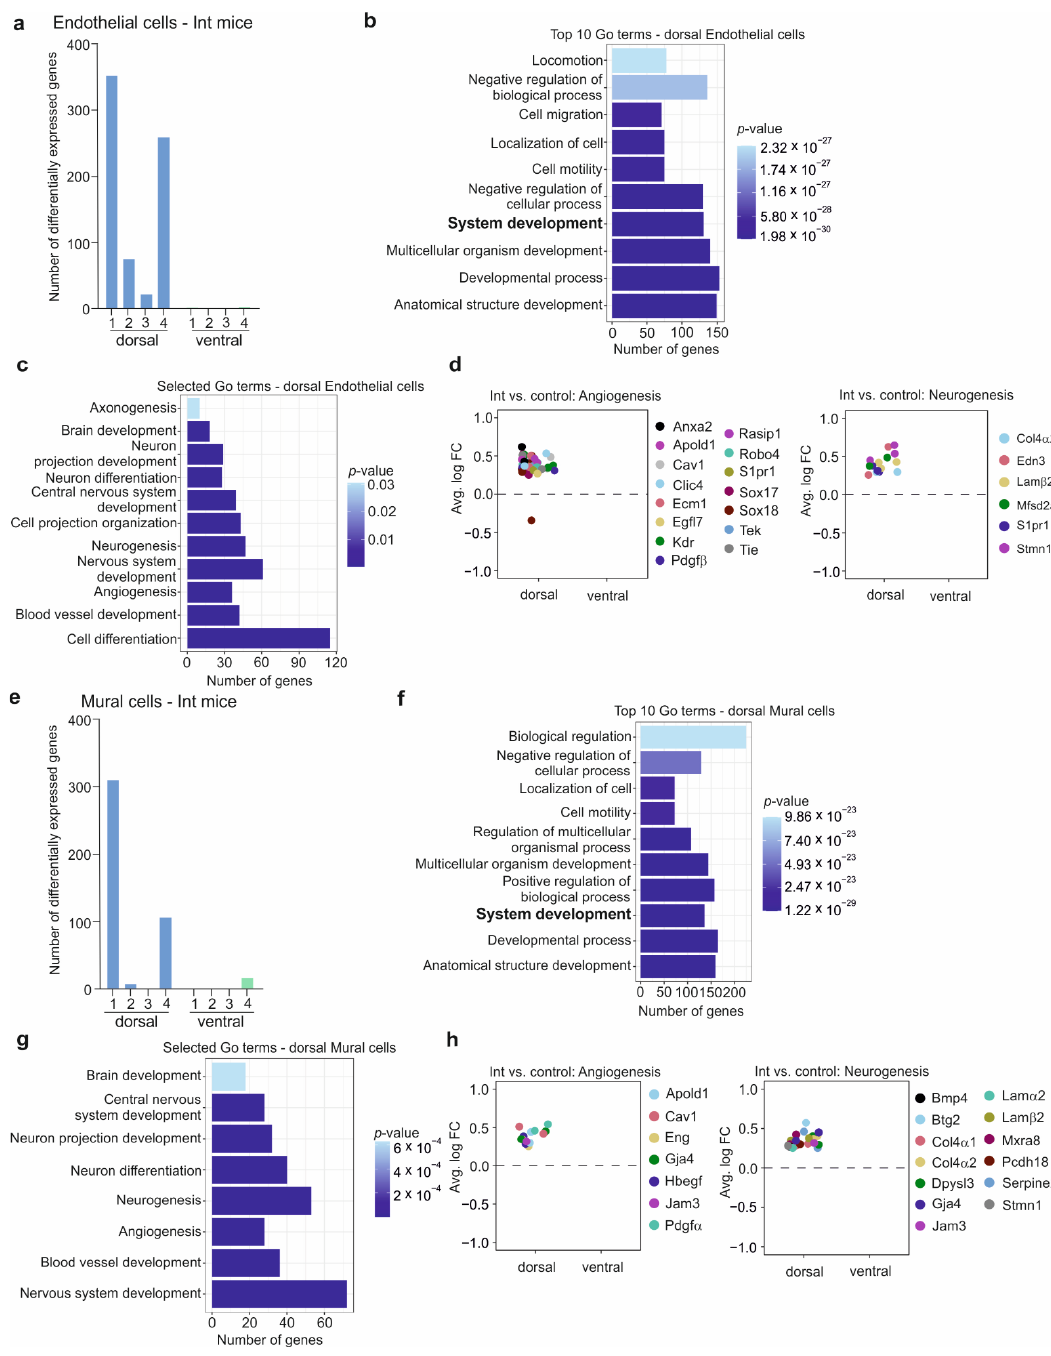
Figure 5. Chronic social defeat stress induces an endothelial and mural cells response in the